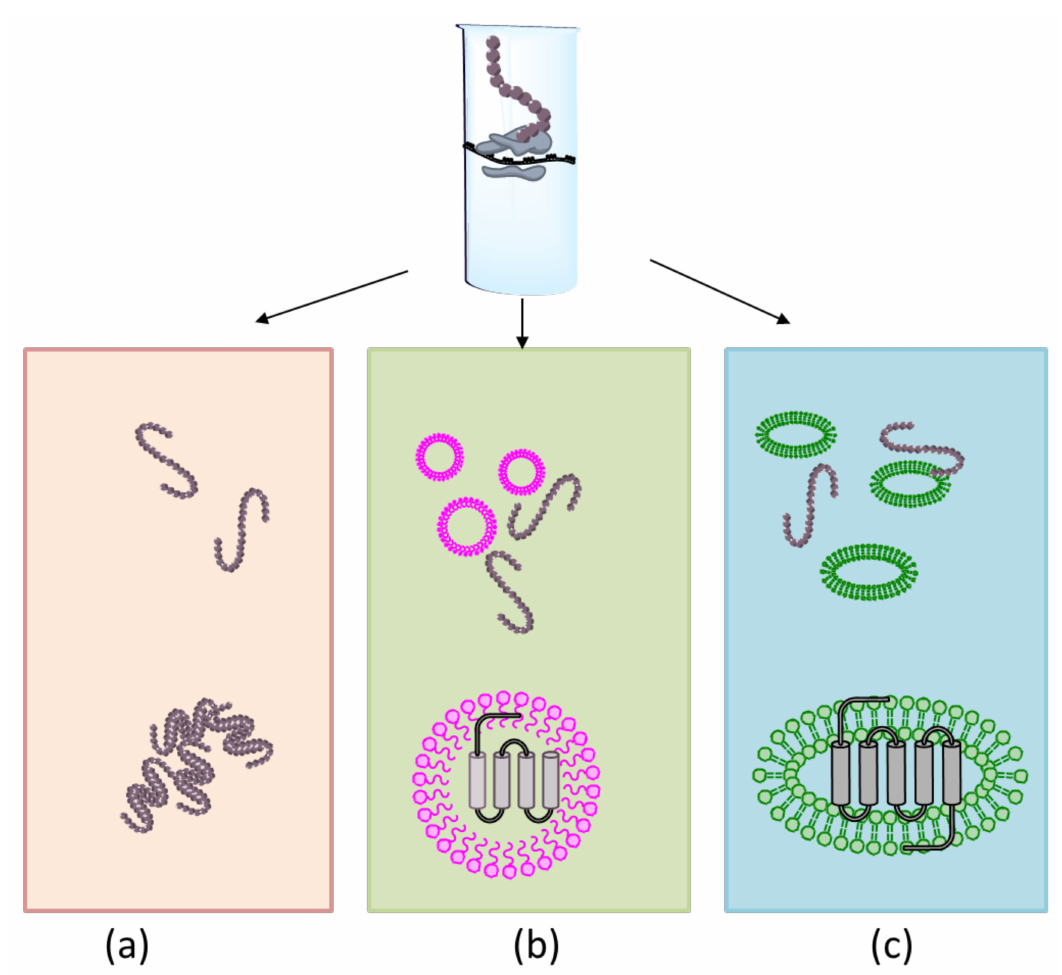
Figure 4. CF methodology for synthesis of MPs. ( a ) In the absence of hydrophobic compounds, the MPs can be produced as precipitates (P-CF). ( b , c ) The addition of detergents (D-CF) or lipids (L-CF) stimulates MPs synthesis in a soluble